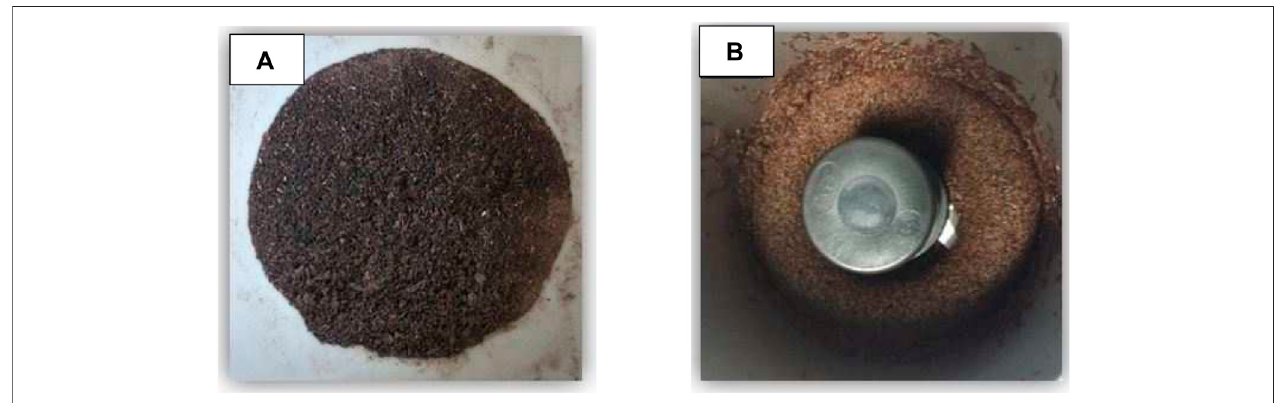
FIGURE 6 | Grinded G. gracilis: (A) freeze-dried biomass and (B) fresh